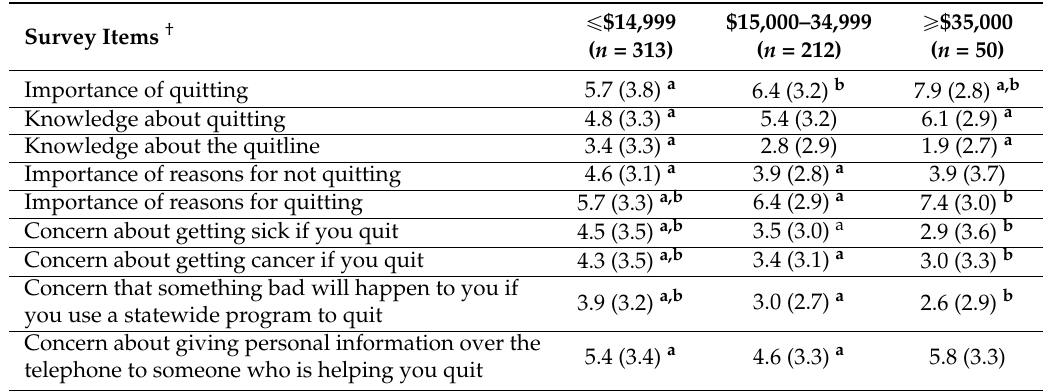
Table 3. The significant differences among responses between current/former tobacco users with different income levels.